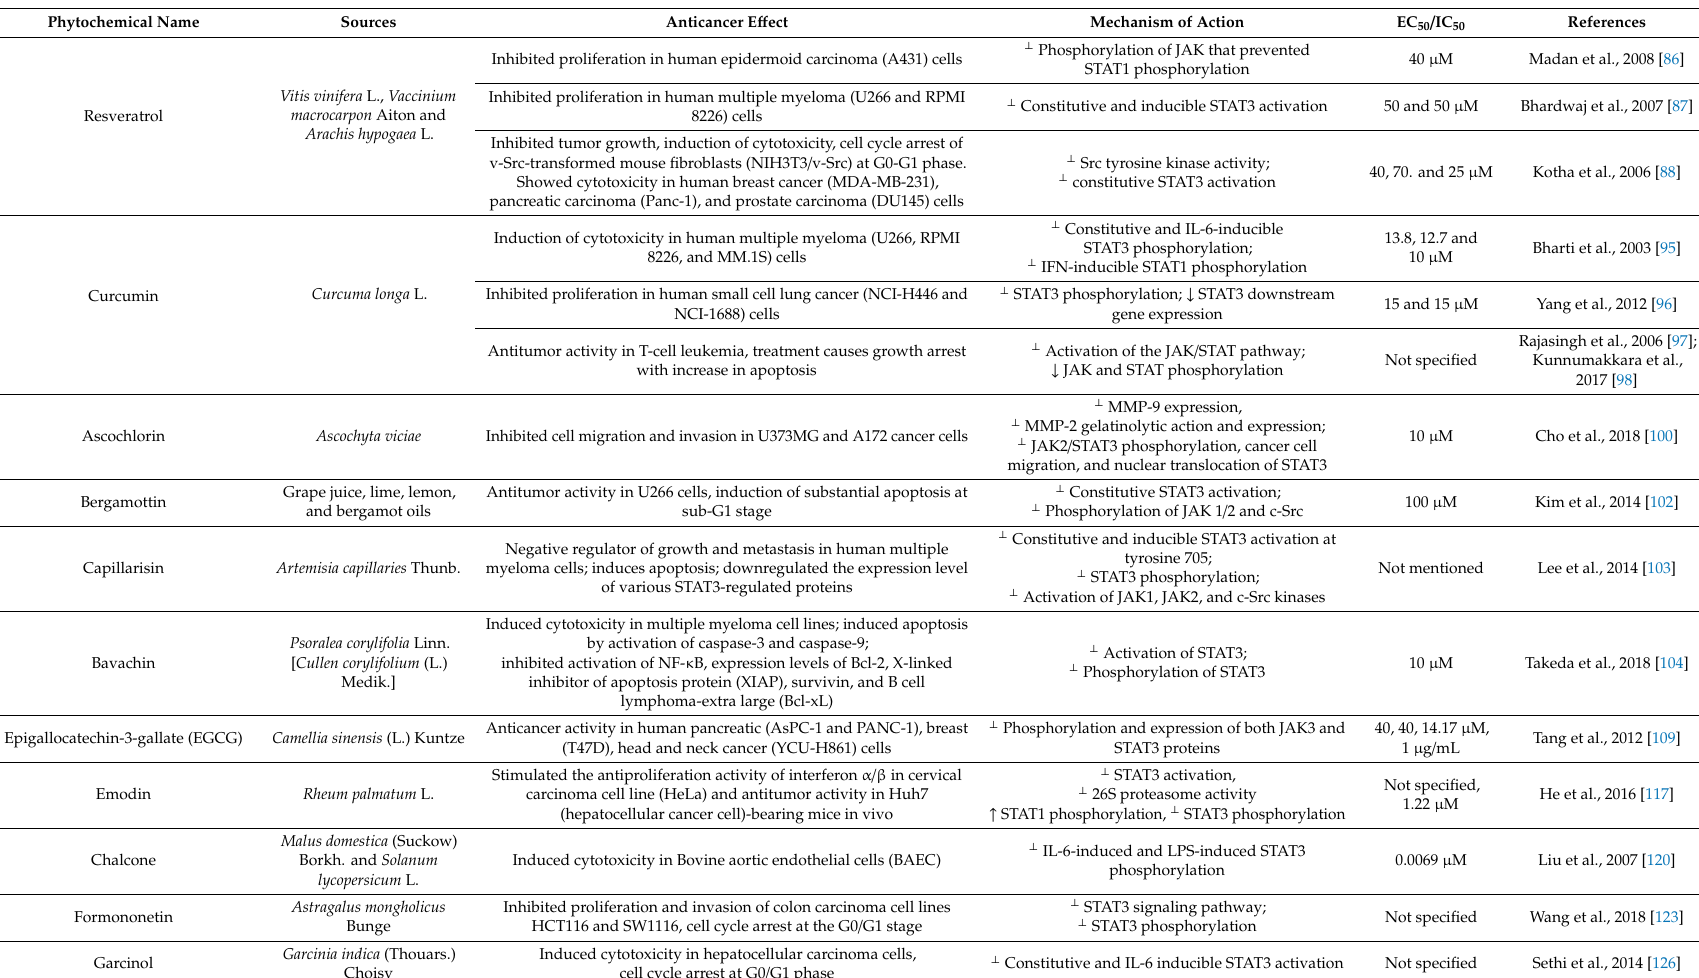
Table 1. Potential anticancer activities of phenolics and polyphenols correlated with inhibition of the JAK / STAT signaling